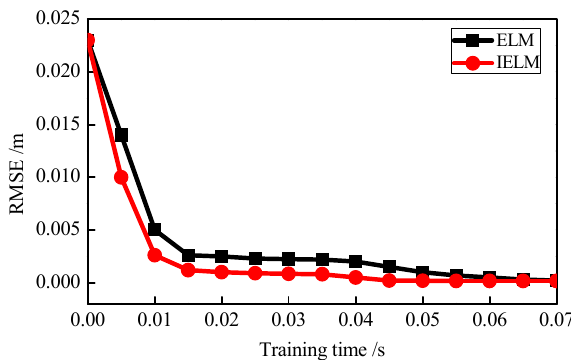
Figure 18. Curves of convergence performance.